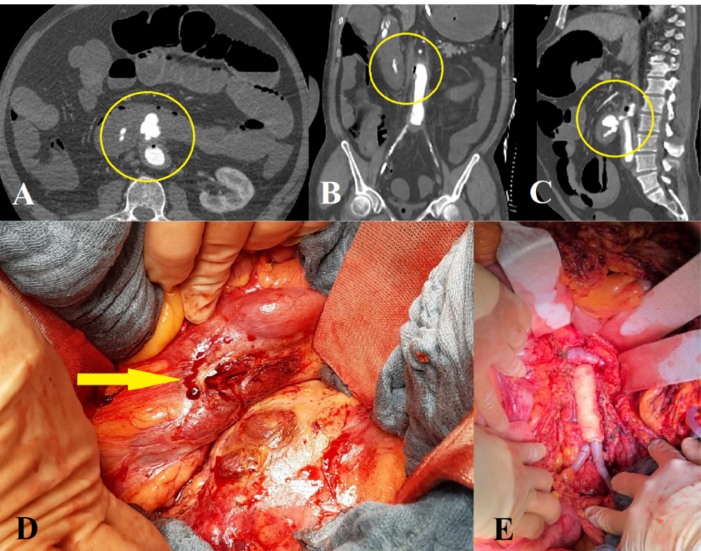
Figure 3. Open surgical repair of a patient with a secondary aortoenteric fistula. Axial ( A ), coro- nary ( B ) and sagittal ( C ) views of a computer tomography angiography showing contrast agent in the duodenum and air inside the aorta (Department of Radiology, University Medical Center Regensburg). ( D ) Arrow showing fistulous connection point. ( E ) Aortic reconstruction with homo- graft interponation.